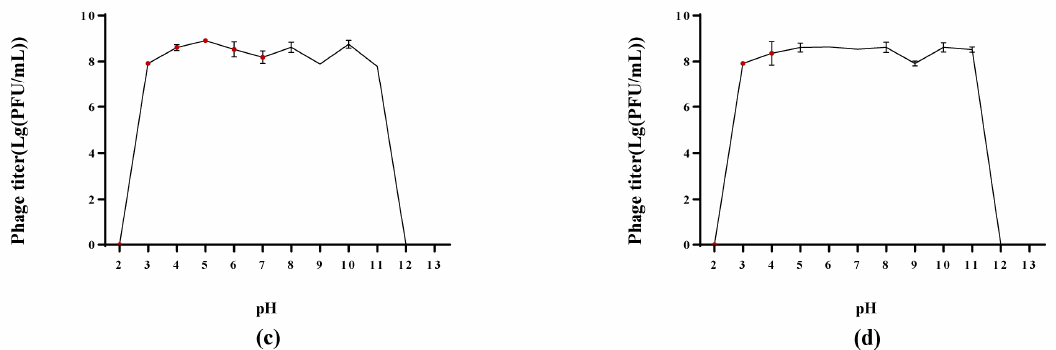
Figure 5. Biological characterization of phages. ( a ) Stability at different pH of PSE-D1. ( b ) Stability at different pH of PST-H1. ( c ) Stability at different temperatures of PSE-D1. ( b ) Stability at different temperatures of PST-H1.